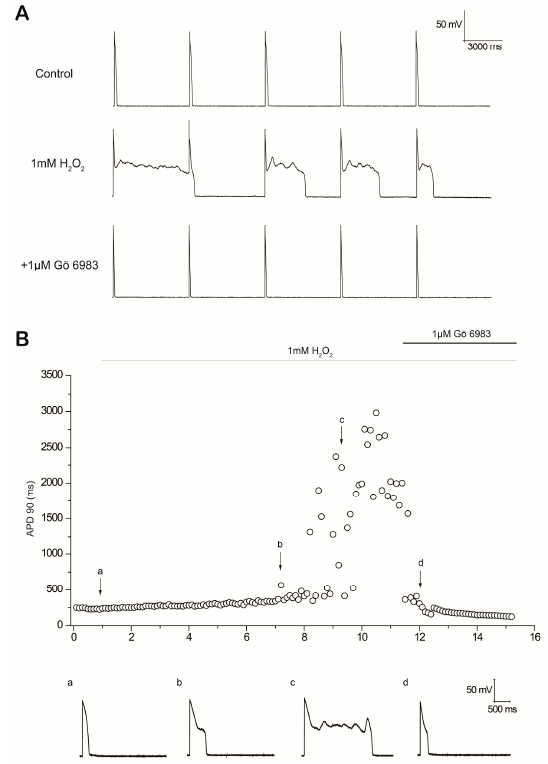
Figure 3. Suppression of H 2 O 2 -induced early afterdepolarizations (EADs) by the PKC inhibitor Gö 6983. ( A ) Gö 6983 completely suppressed all H 2 O 2 -induced EADs and significantly shortened action potential duration (APD). The representative five consecutive action potentials (APs) are shown in each period; ( B ) Time course of APD 90 in a myocyte treated with Gö 6983 after EADs were induced by H 2 O 2 . APs under control conditions (a), after perfusion with H 2 O 2 for 6 min (b) and 8 min (c), and after application of Gö 6983 (d) are shown below.